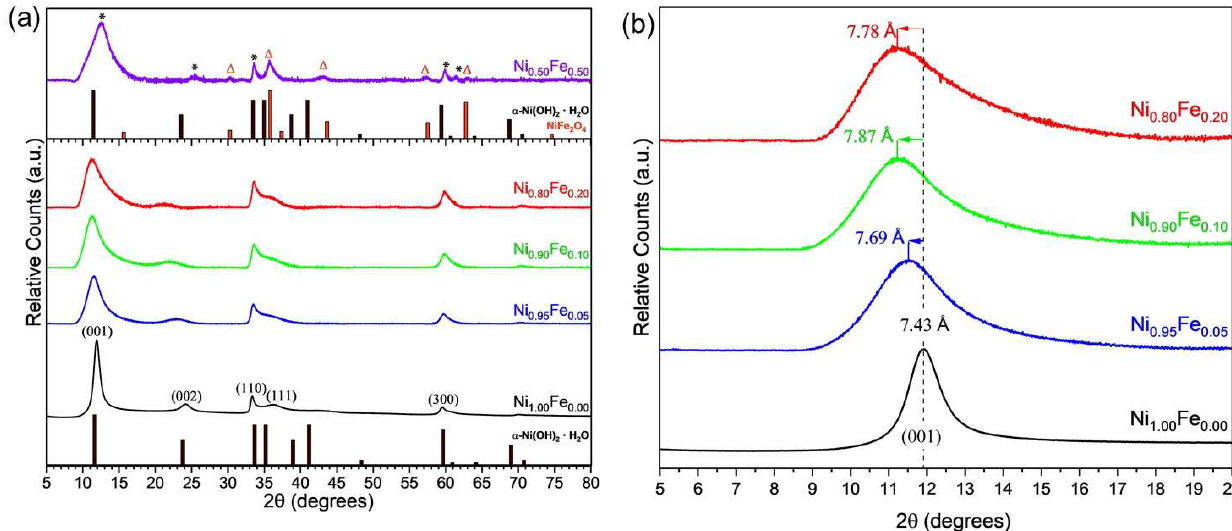
Figure 3. X-ray diffraction patterns of ( a ) Fe-substituted nanosheets at 0, 5, 10, 20, and 50 at % Fe substitution ratio (notated as Ni 1.00 Fe 0.00 , Ni 0.95 Fe 0.05 , Ni 0.90 Fe 0.10 , Ni 0.80 Fe 0.20 , and Ni 0.50 Fe 0.50 , respec- tively), ICDD data of α-Ni(OH) 2 (ICDD# 022-0444) is indexed with the 0, 5, 10, 20 % Fe substituted respectively), ICDD data of α -Ni(OH) 2 (ICDD# 022-0444) is indexed with the 0, 5, 10, 20% Fe samples for reference, ICDD data for NiFe 2 O 4 (ICDD# 066-0778) and α-Ni(OH) 2 (ICDD# 022-0444) substituted samples for reference, ICDD data for NiFe 2 O 4 (ICDD# 066-0778) and α -Ni(OH) 2 (ICDD# are indexed with the 50% NiFe sample (α-Ni(OH) 2 peaks denoted by * and NiFe 2 O 4 by ∆) for refer- 022-0444) are indexed with the 50% NiFe sample ( α -Ni(OH) 2 peaks denoted by * and NiFe 2 O 4 by ∆ ) ence; ( b ) and expanded region of the XRD pattern between 5° and 20° 2θ showing shifts in the (001) for reference; ( b ) and expanded region of the XRD pattern between 5 ◦ and 20 ◦ 2 θ showing shifts in diffraction and corresponding d-spacings. the (001) diffraction and corresponding